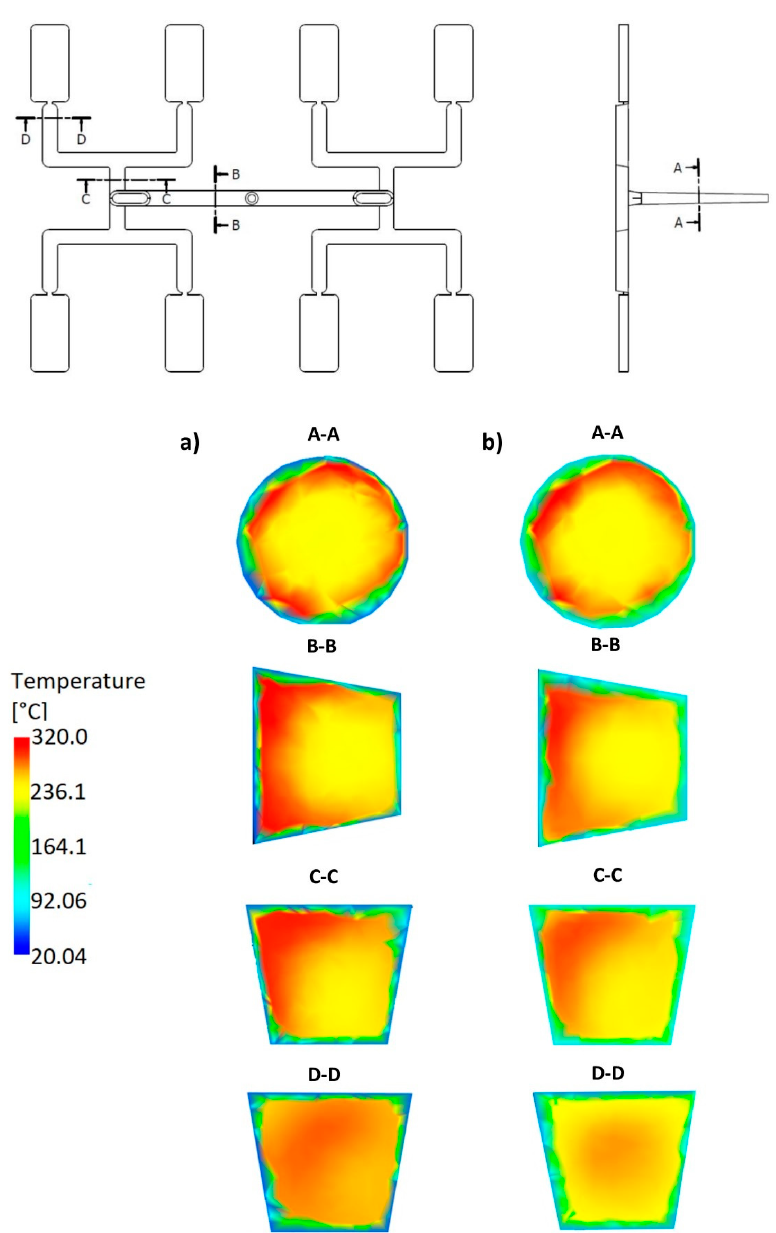
Figure 24. Temperature distribution in the selected cross-sections of the runners for different thermal diffusivity at high injection rate in the case of the geometry with one overturn element G1 : ( a ) α = 0.005 mm 2 /s ( I m = − 33%), and ( b ) α = 5 mm 2 /s ( I m = − 17%).